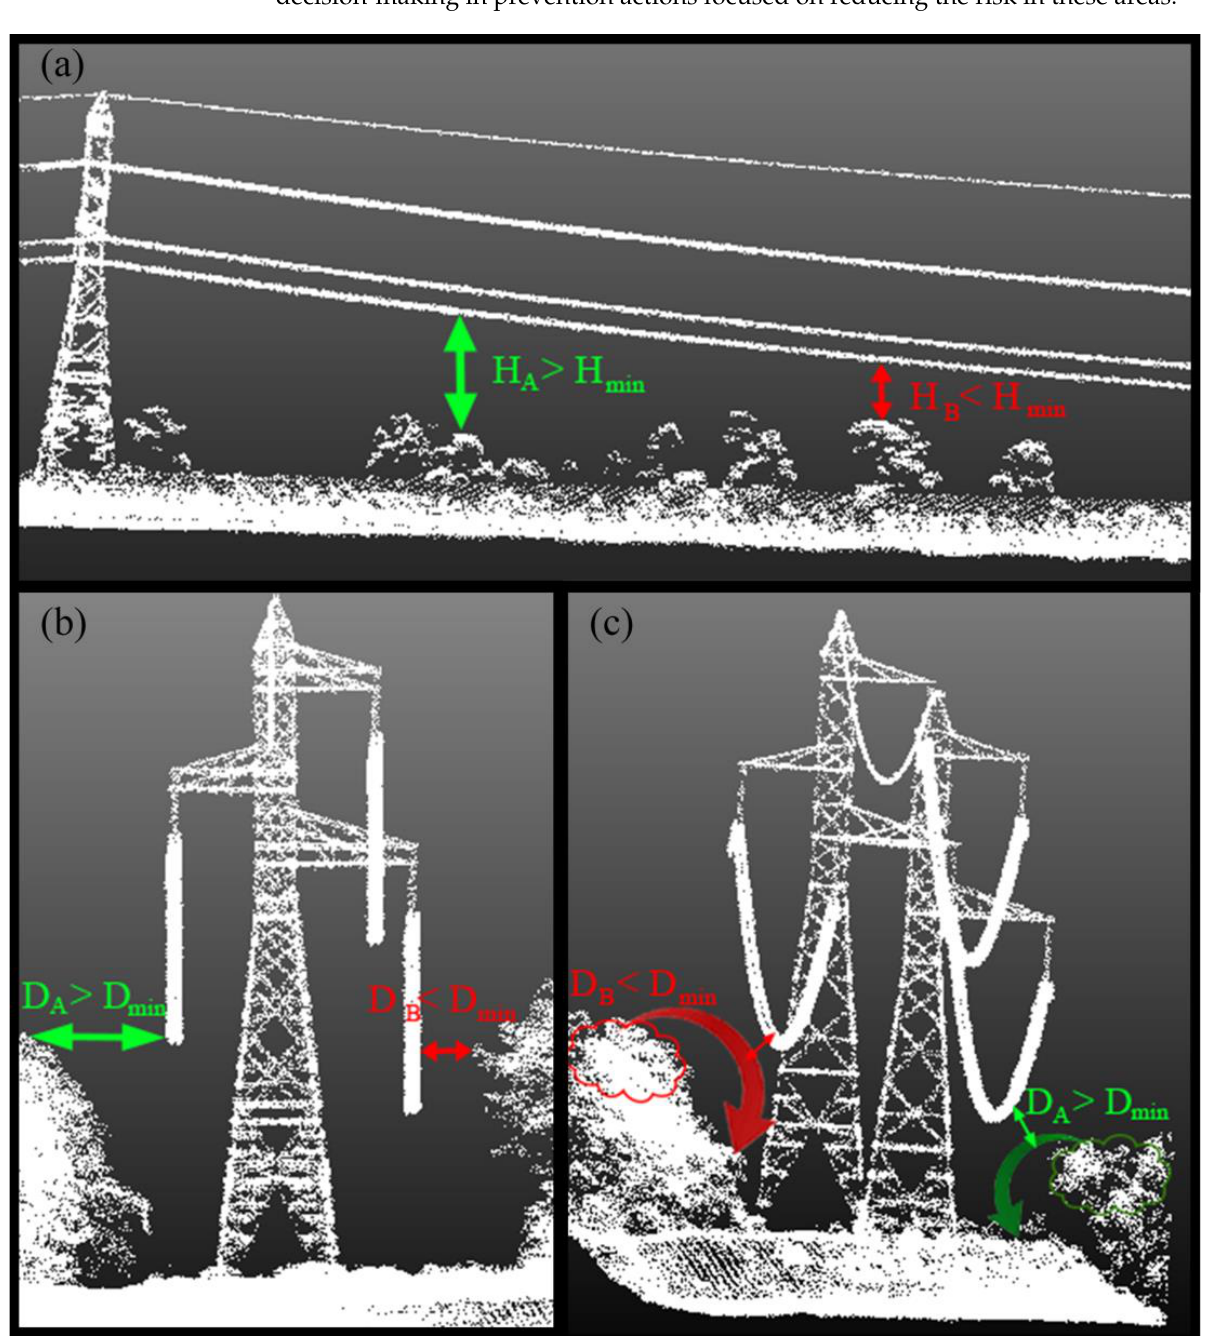
Figure 6. Geometric criteria for defining risk areas: ( a ) Height risk; ( b ) Distance risk; and ( c ) Fall risk. H min and D min correspond to the minimum heights and distances to the vegetation according to the regulations in each country. D A (green) represents a valid distance, while D B (red) represents a non-valid distance and thus a risk area.